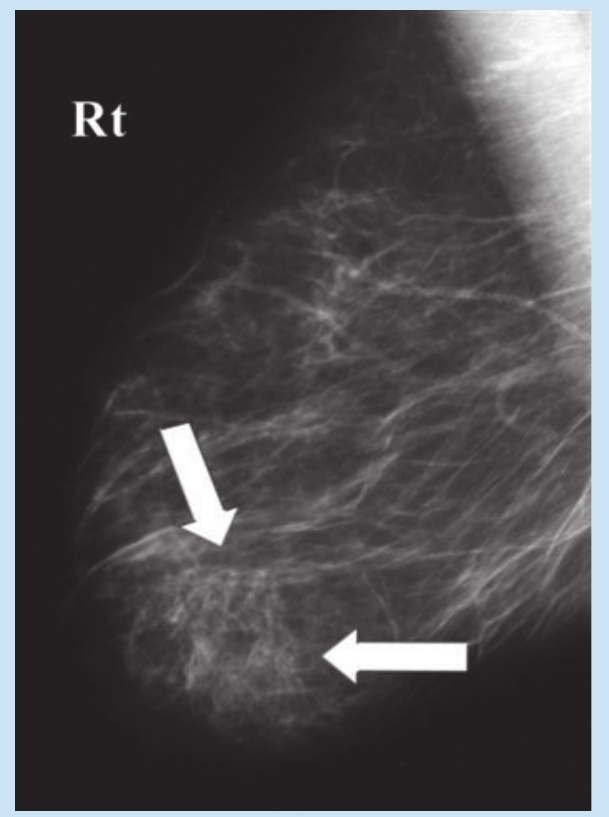
Fig. 1. MG. Area of increased density in the lower medial quadrant of the right breast near the areola. Distortion of the glandular architecture.